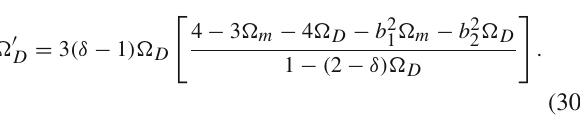
Defining the following dimensionless density parameter ρ r (cid:5) = r ρ